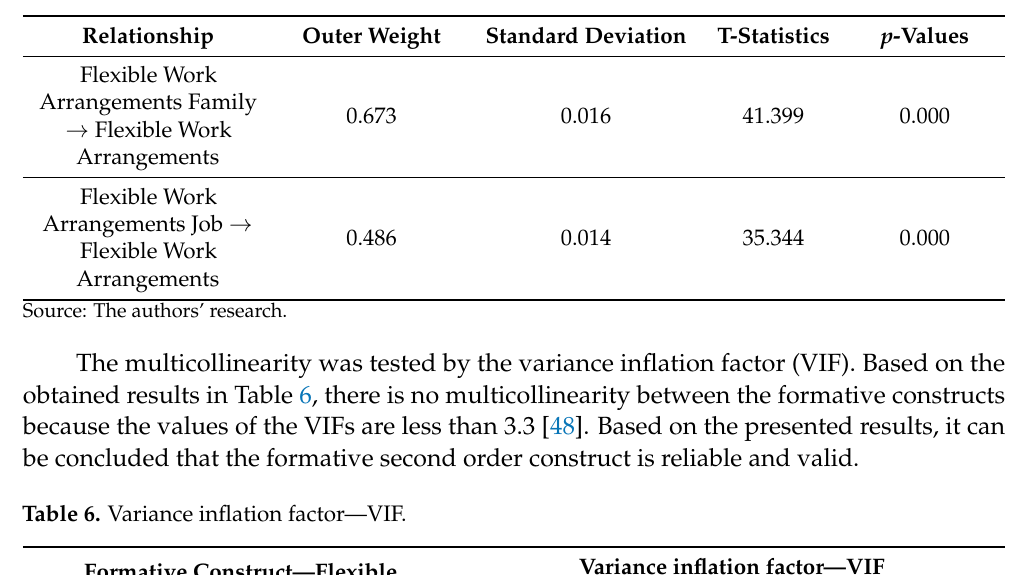
Table 5. Analysis of the formative construct of the external model.